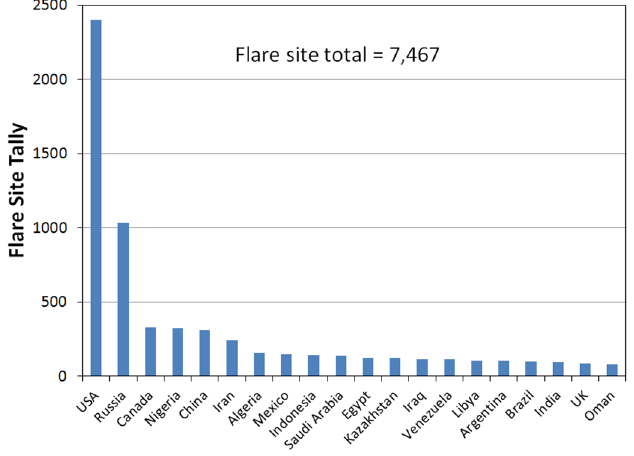
Figure 9. Flare tally by country for 2012.